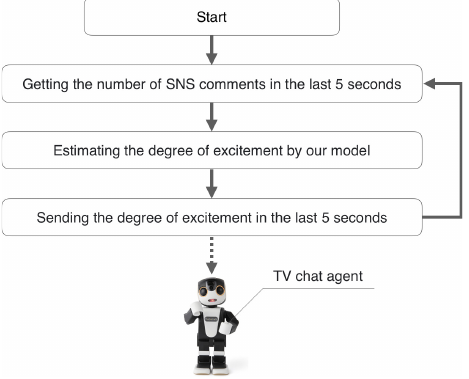
Figure 1. The processing flow of our model.